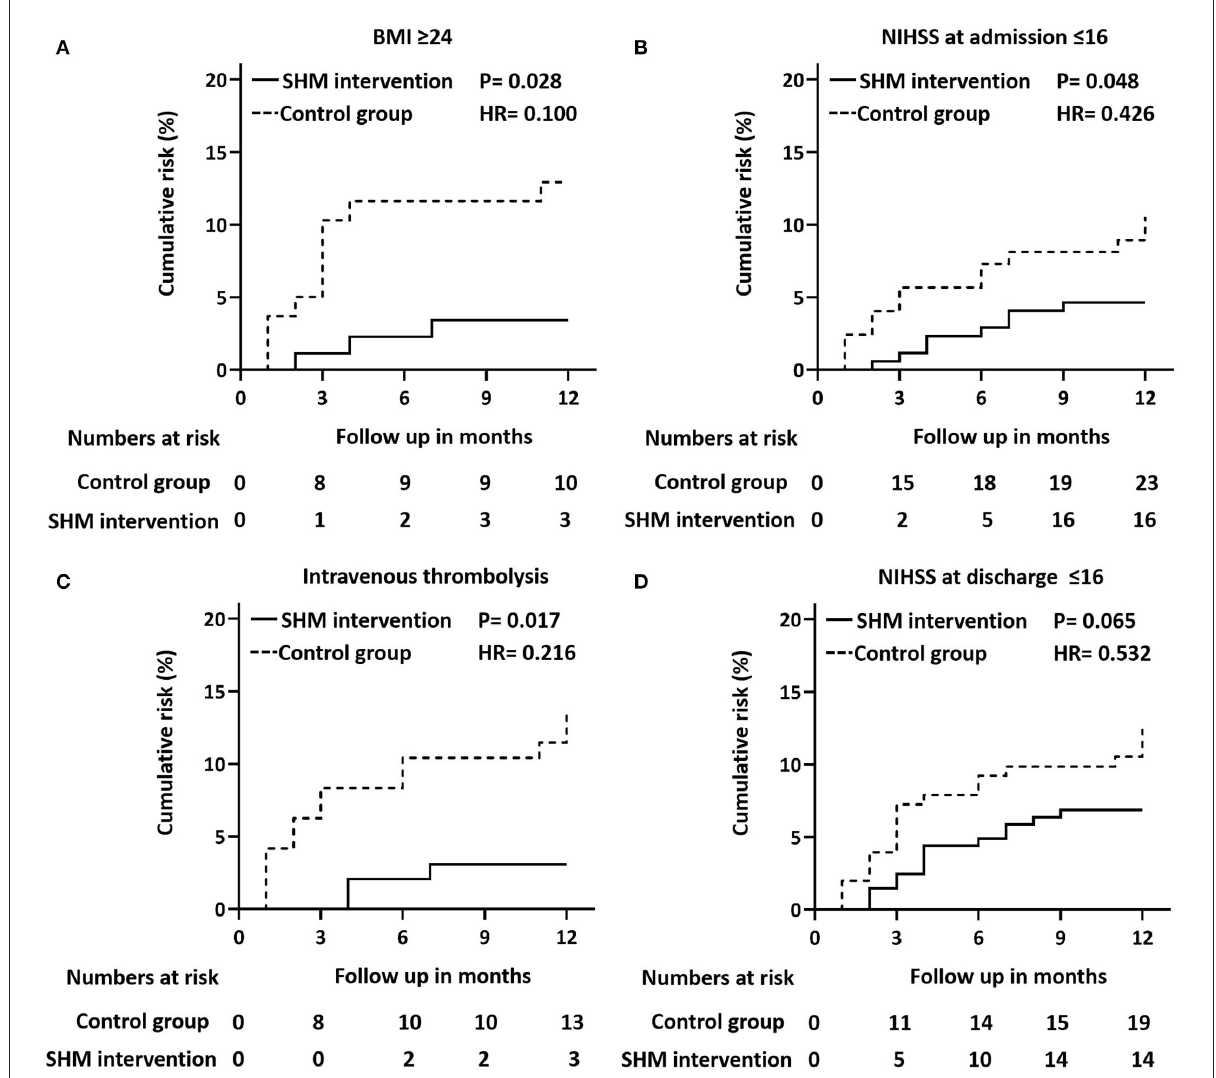
FIGURE4 Cox proportional hazard model plots. Cox proportional hazard models plots of outcomes stratified by BMI ≥ 24 kg/m 2 (A) , NIHSS at discharge ≤ 16 (B) , intravenous thrombolysis (C) , and NIHSS at admission ≤ 16 (D) . P -values for the overall comparison of the difference between the control group and the SHM intervention group. BMI, body mass index; SHM, stroke health manager; NIHSS, National Institutes of Health Stroke